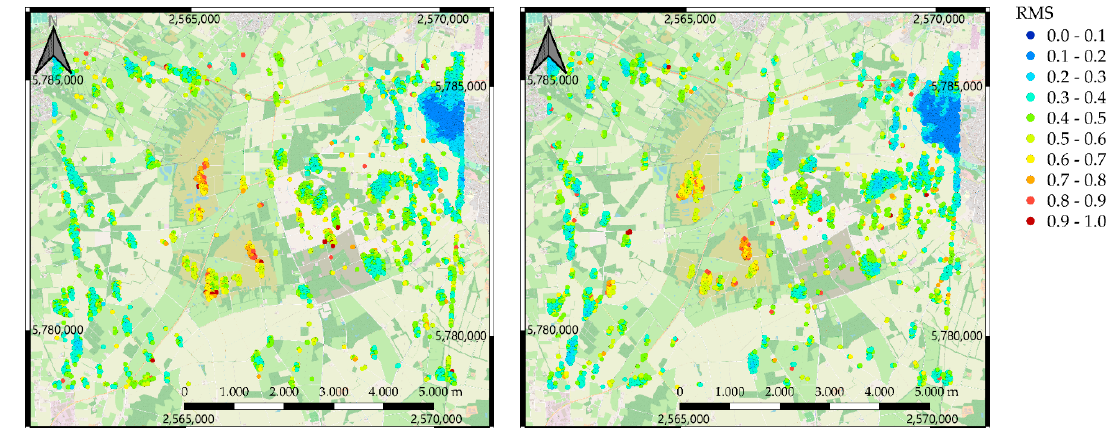
Figure 6. Root Mean Square (RMS) of residual phase. Left-hand side from ascending orbit, right-hand side from descending orbit.